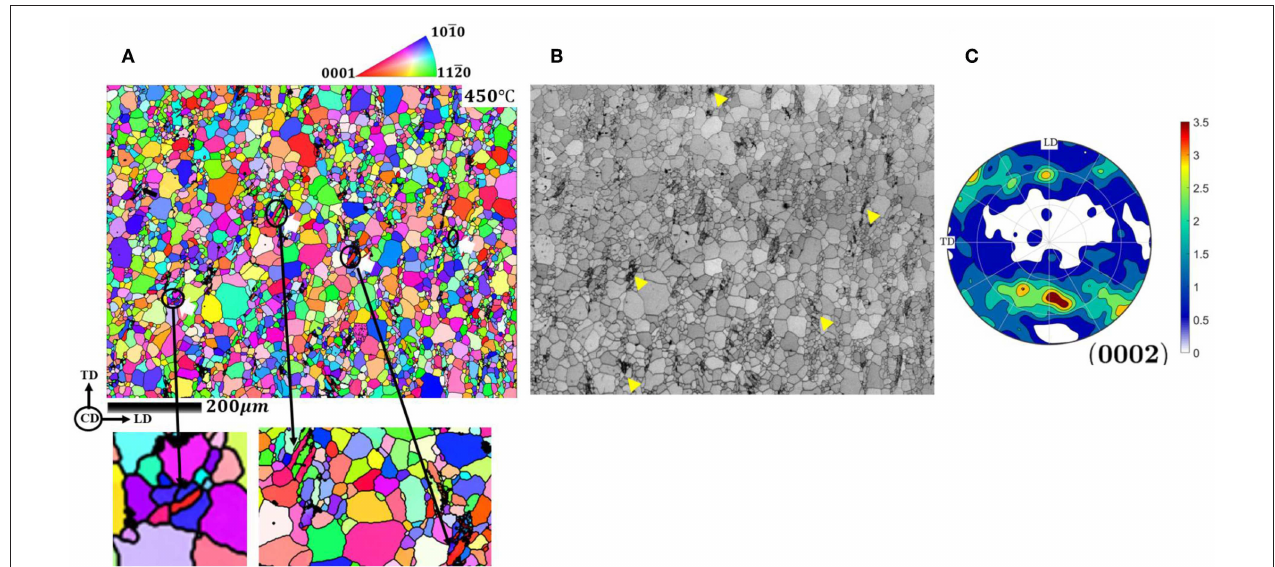
FIGURE 10 | EBSD map (at 450 ◦ C for 60min) in inverse pole figure coloring (A) and image quality (B) color coding. Recalculated (0002) pole figure shown in (C) . Portions in (A) are zoomed in to shown the still un-recrystallized twins, marked by white arrows in (A) . Yellow markers in (B) indicate the fine grains recrystallizing near Zr-rich particle